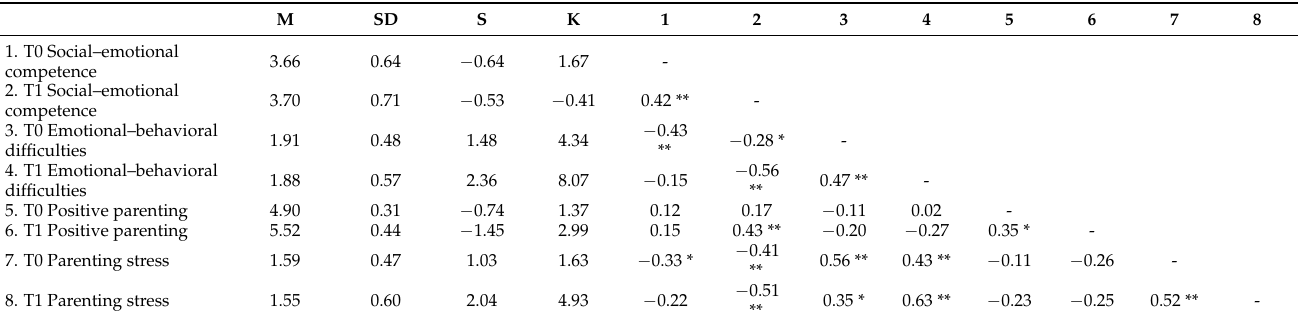
Table 1. Means (M), standard deviations (SD), skewness (S), kurtosis (K), and Pearson correlation coefficients of study variables at T0 and T1.